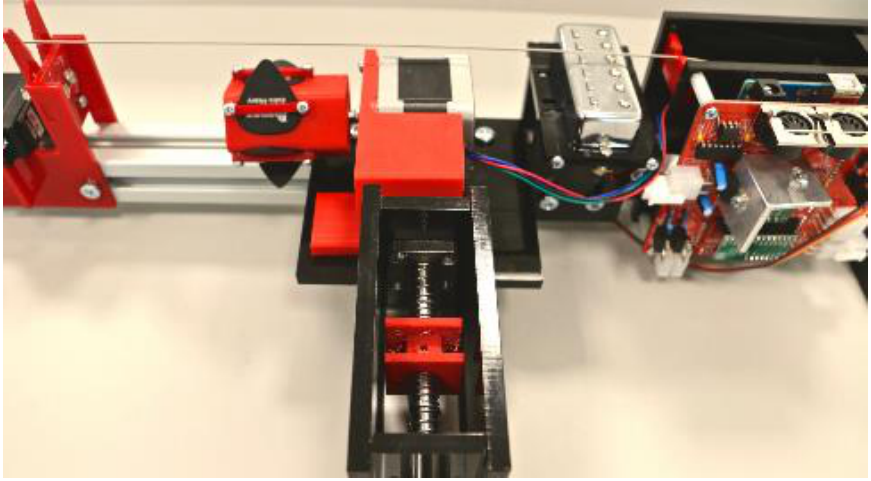
Fig. 5. Group 2: Note the compliant actuation for the picking mechanism.